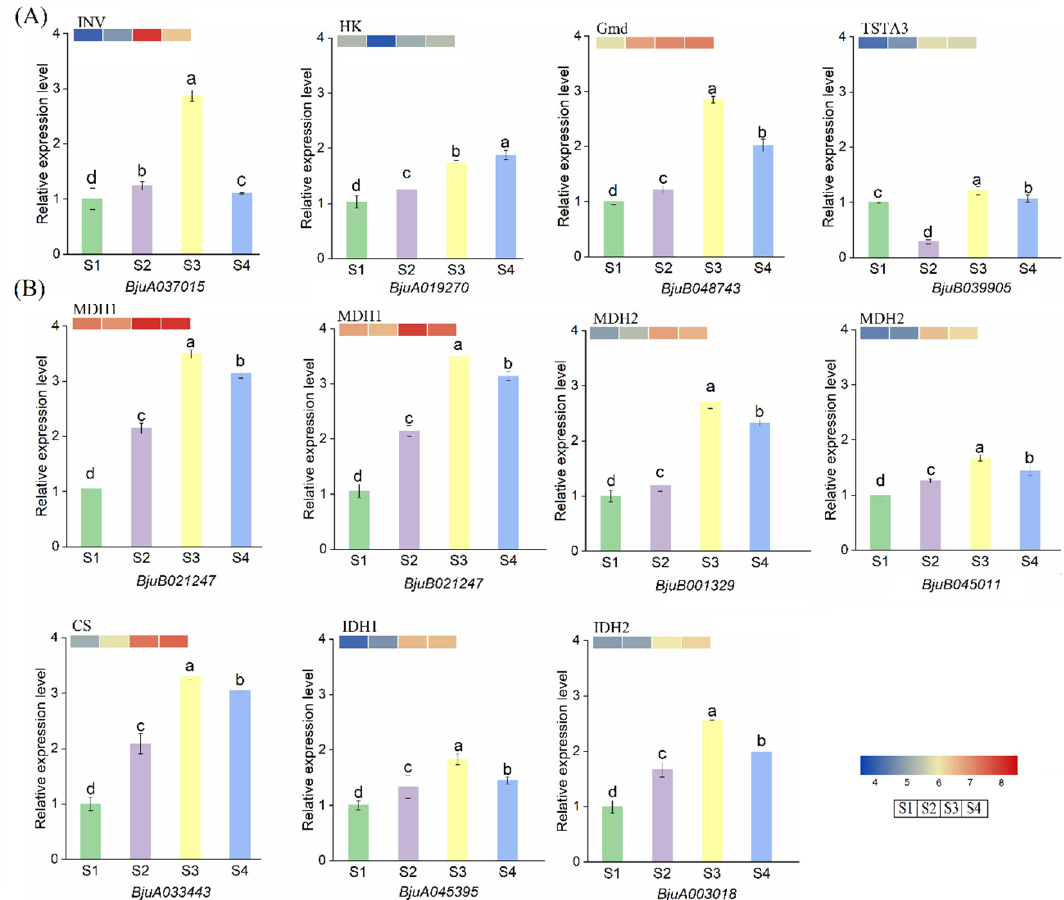
Figure 9. Relative expression levels (target gene vs. UBC) of sugar- and acid-related enzyme genes in four different developmental stems of B. juncea . ( A ) Relative expression levels of sugar-related enzyme genes. ( B ) Relative expression levels of acid-related enzyme genes. Colored squares represent enzyme gene transcript abundance. The different letters (a–d) on the vertical bars mean significant differences at the 0.05 level. Three biological replicates were performed for each gene.